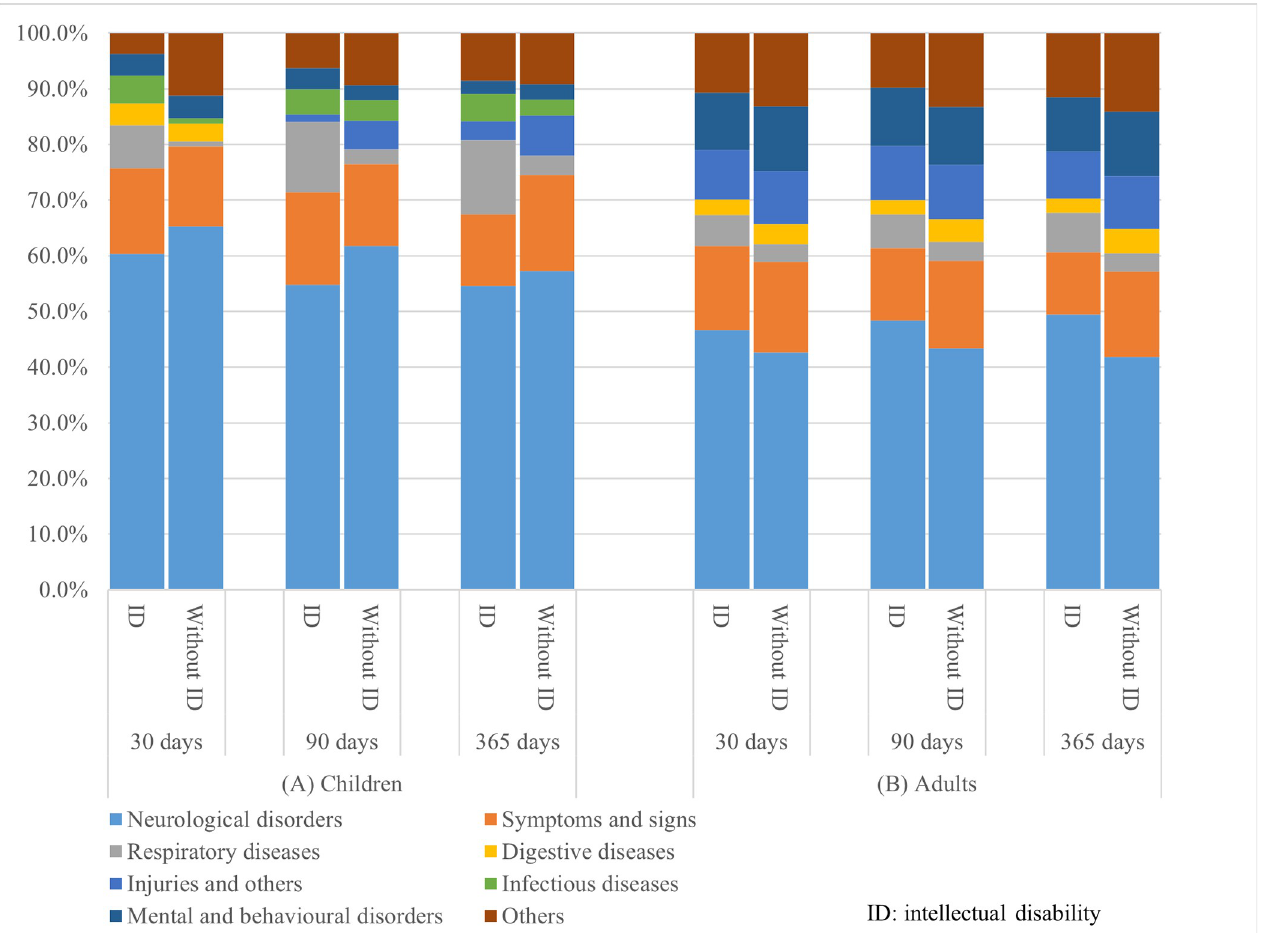
Fig 2. The six most frequent primary diagnoses at the first readmission within each follow-up period for children (A) and adults (B) by intellectual disability status.